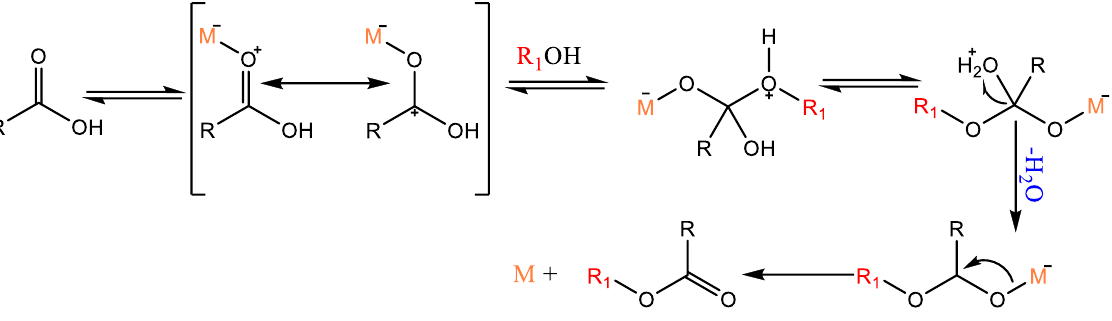
Figure 9. Suggested mechanism for esterification using Cu 2 S (8%) -FeS (10%) /SiO 2 acid